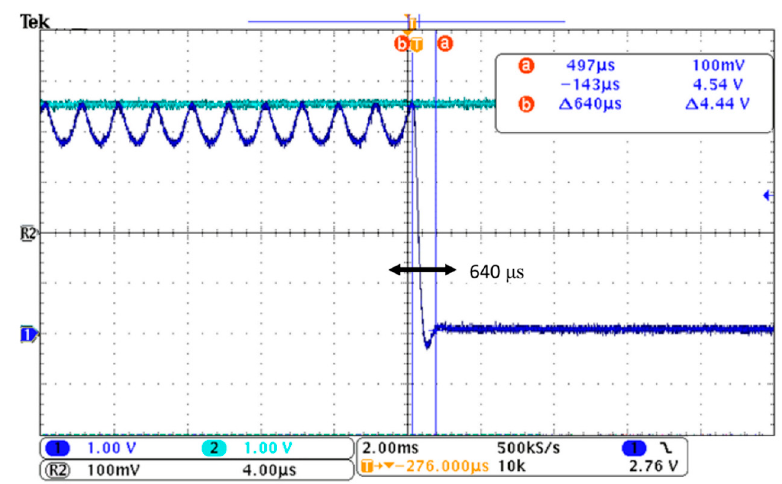
Figure 5. Overvoltage protection.